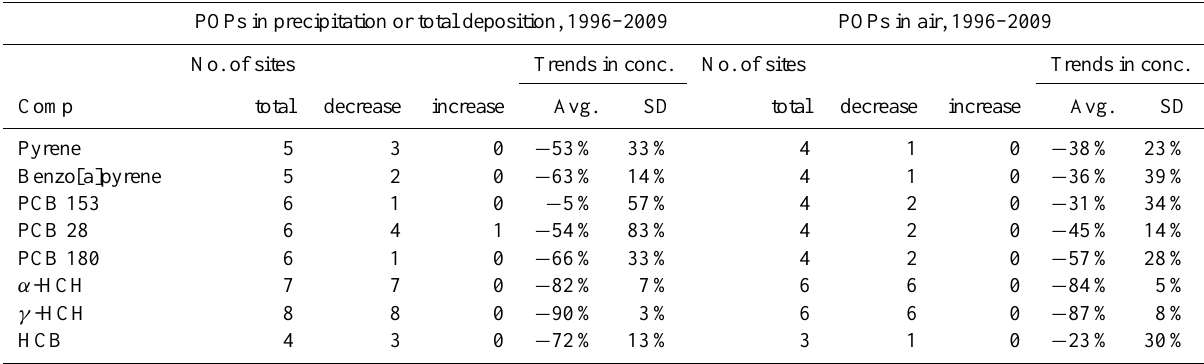
Table 7. Trend analysis for POPs in precipitation and air for the years 1996–2009 (bulk/wet only sampling at sites NO01, DE01, DE09, IS91 and NL91 and total deposition sampling at sites SE02, SE12 and